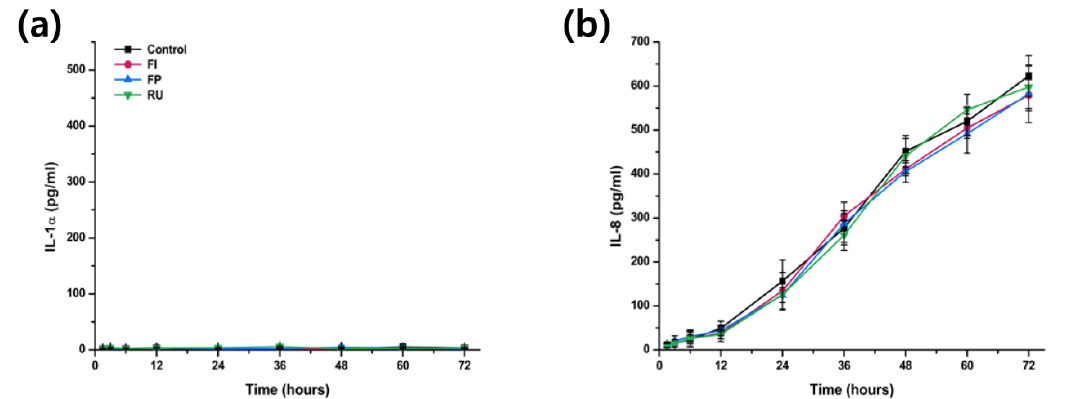
Figure 4. ( a ) Concentration of IL ‐ 1 α and ( b ) IL ‐ 8 released from immortalized human oral fibroblasts (hTERT ‐ hNOF) following exposure to Fuji I (FI), Fuji Plus (FP) and Rely X U200 (RU) for varying duration of time.